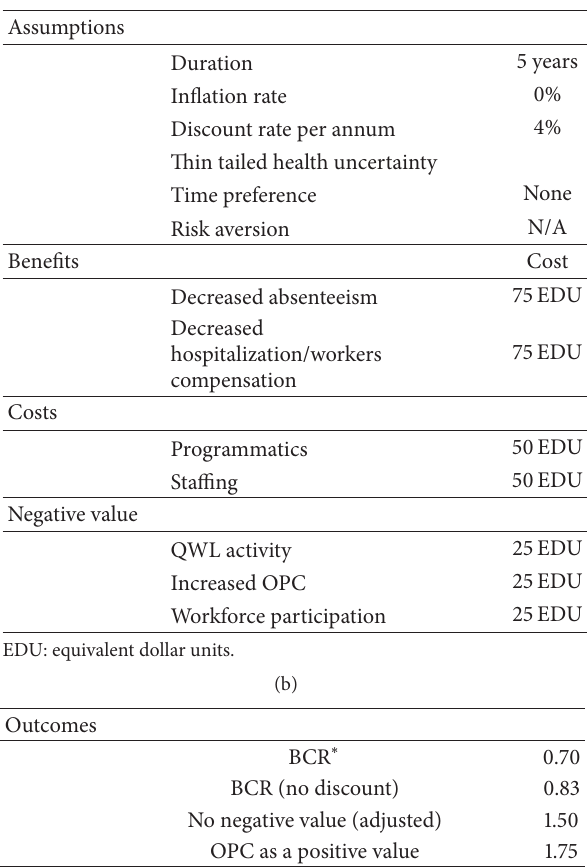
Table 2: The effects of changing basic